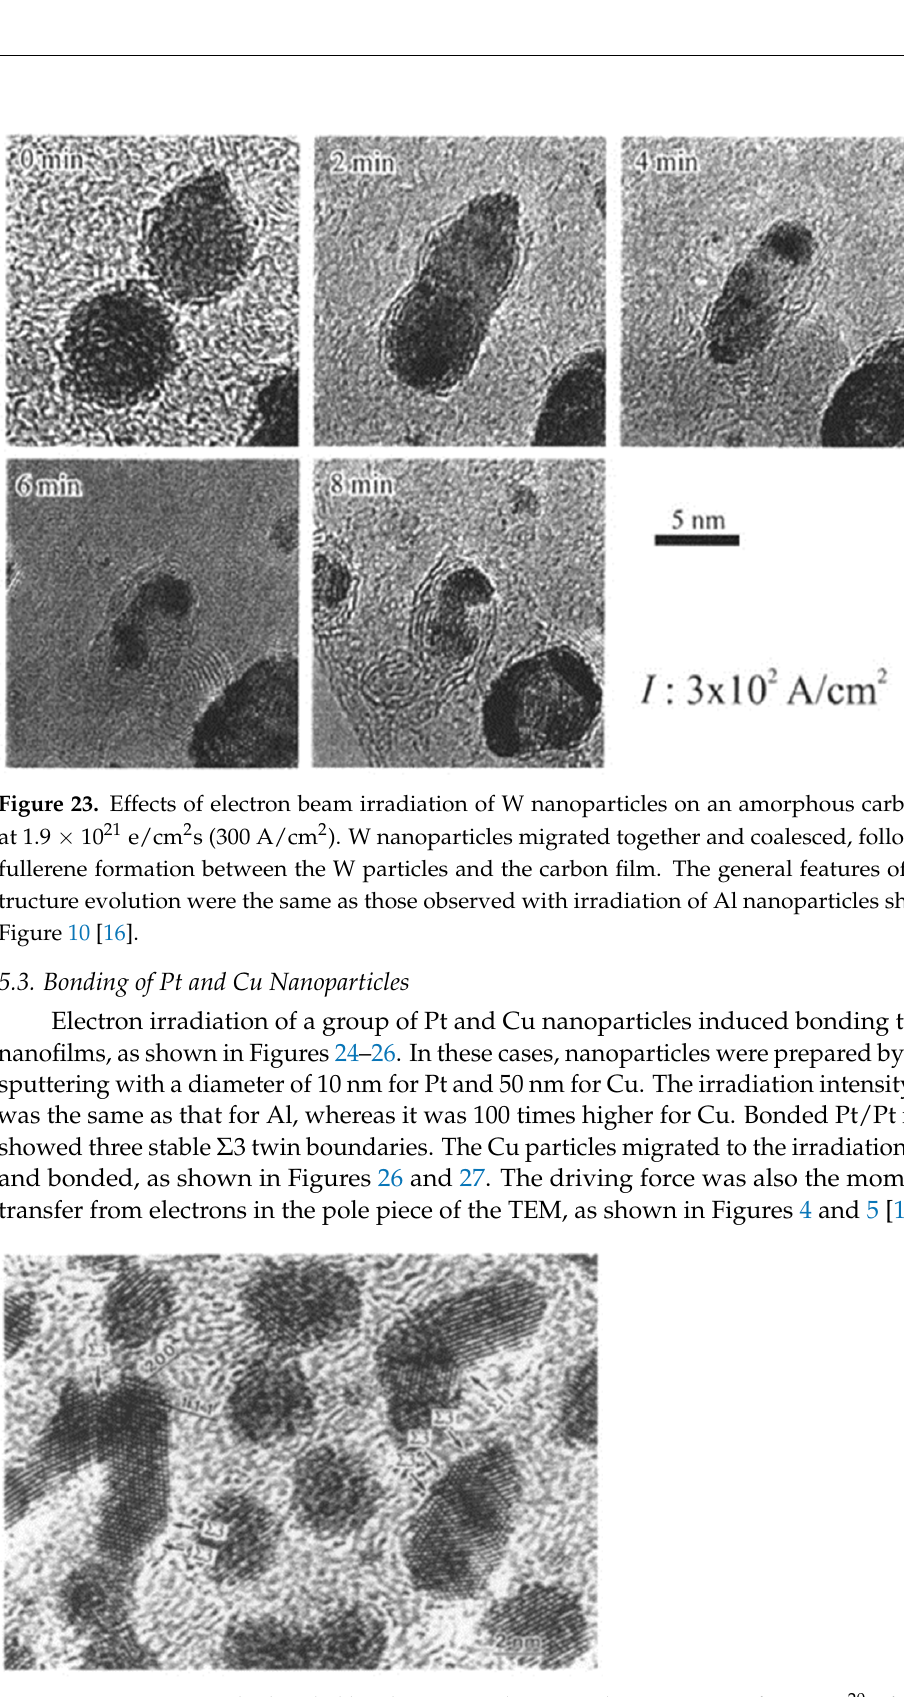
Figure 24. Pt nanoparticles bonded by electron irradiation with an intensity of 2.1 × 10 20 e/cm 2 s for 700 s. The bonded Pt/Pt nanoparticles had tilt boundaries of Σ3 and Σ11 [19].